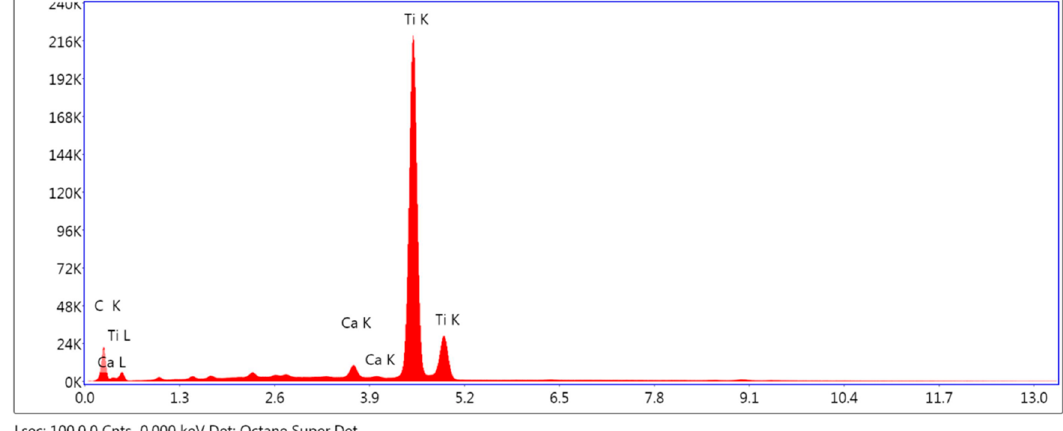
Figure 9. Energy dispersive spectroscopy analysis of SLA.